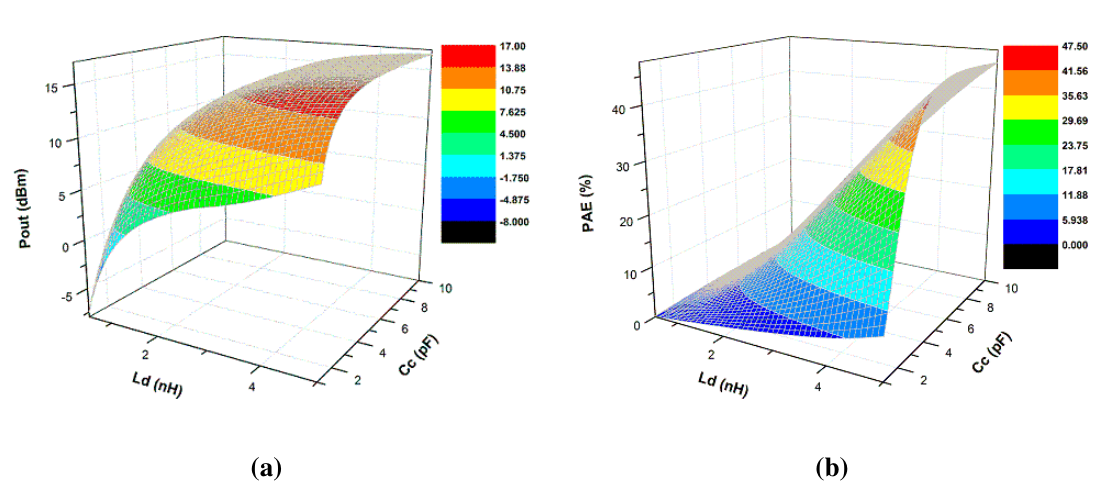
Figure 9. ( a ) RF choke and output coupling versus output power; ( b ) RF choke and output coupling versus power-added